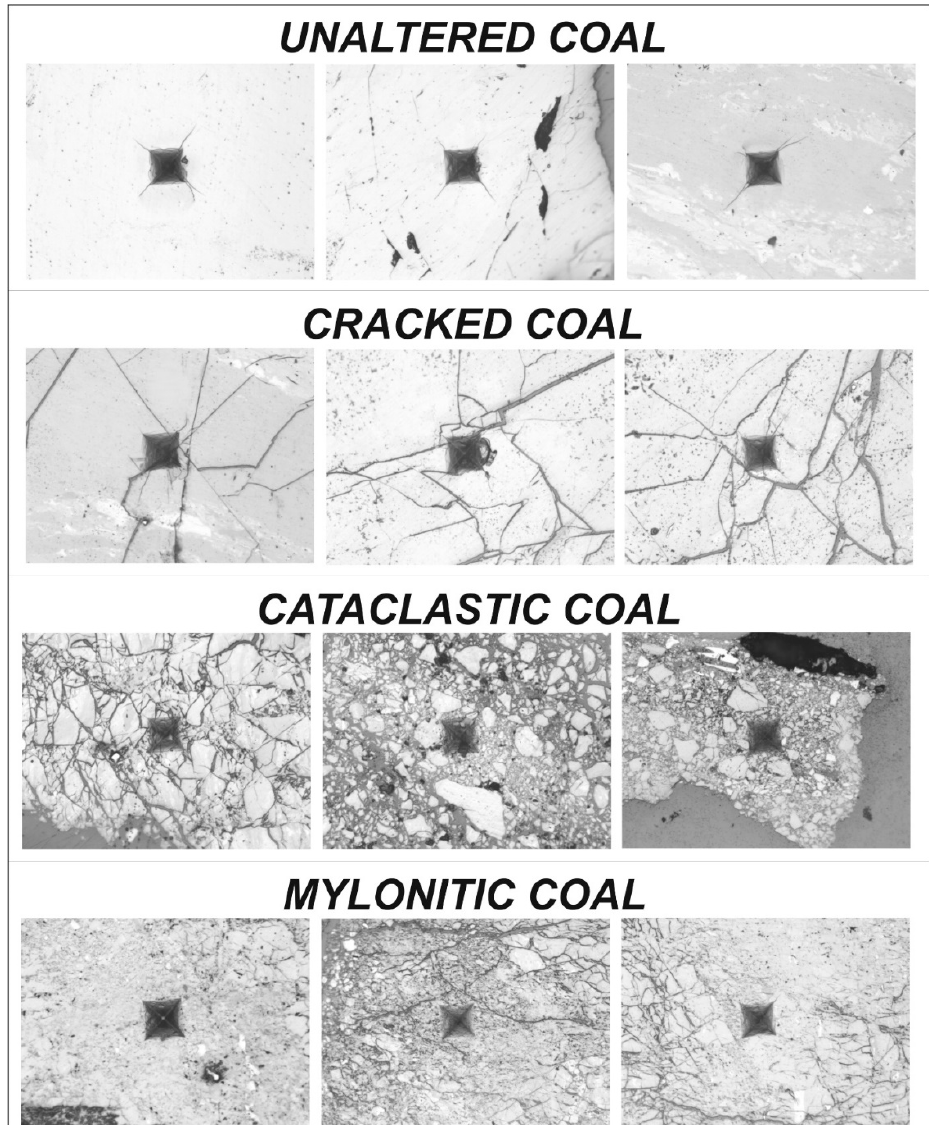
Figure 4. Coal structures in the spots of microhardness measurements. Photographs after the microhardness analysis, with a marked imprint, taken at a magnification of 200 × , reflected light.